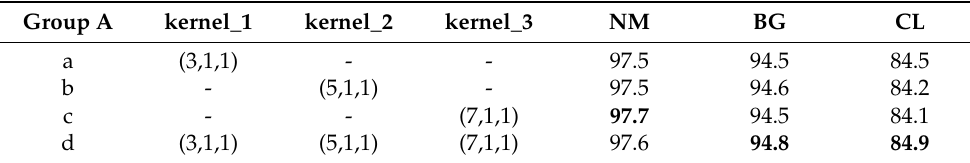
Table 6. Ablation experiments for Multi-scale Temporal Aggregation. Control condition: the different convolutional combination